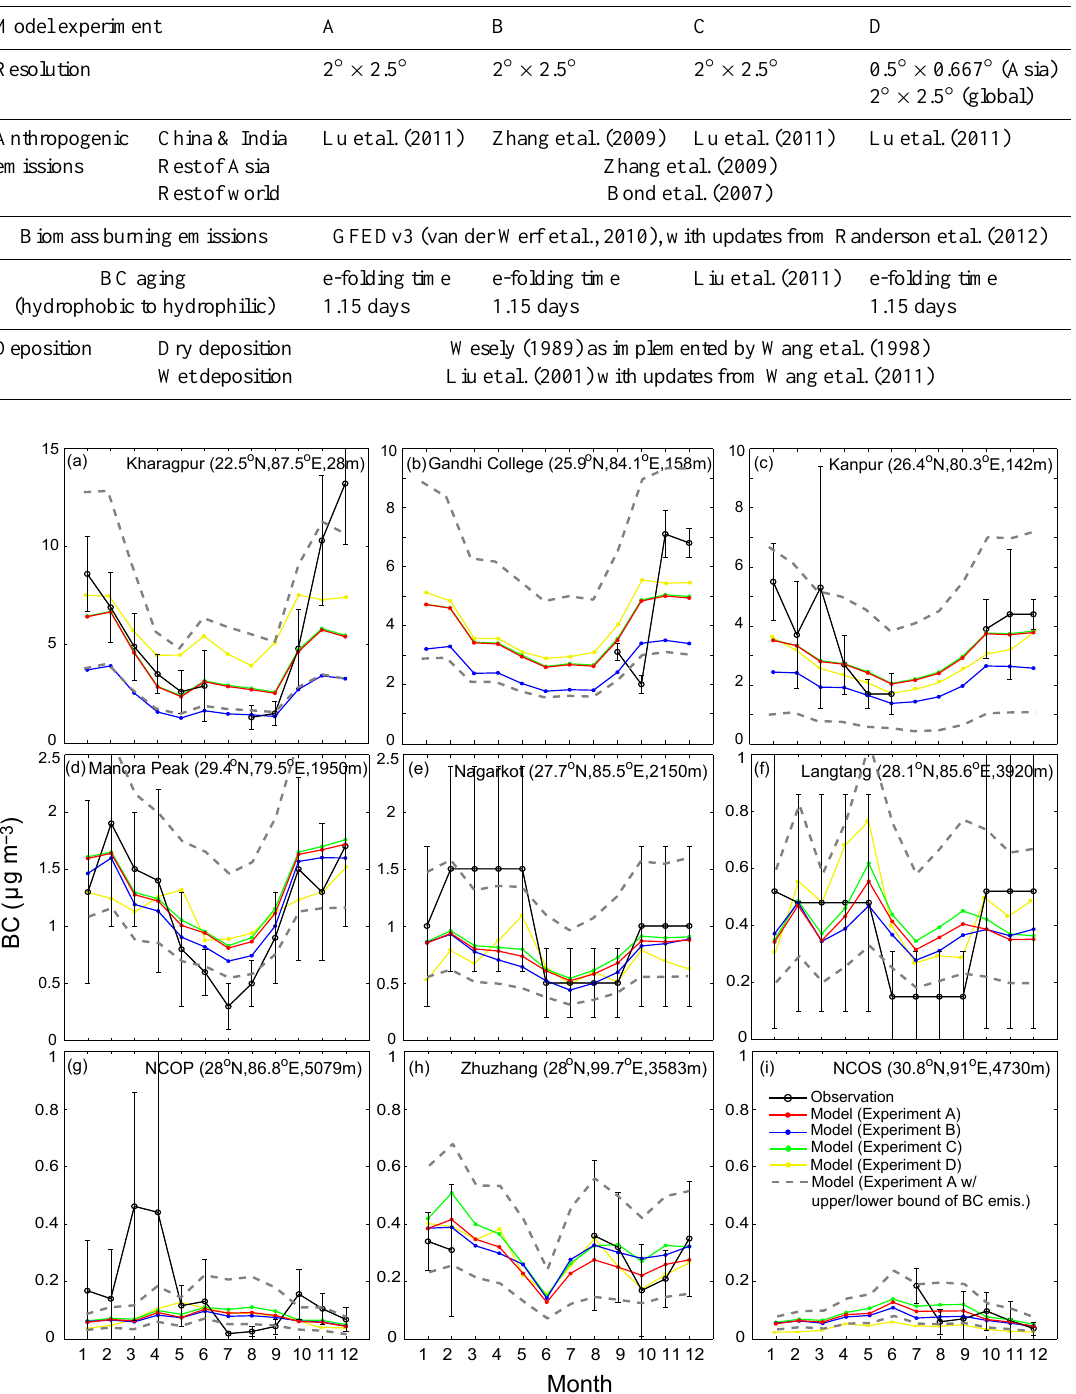
Figure 2. Observed (black curve) and GEOS-Chem simulated (colored curves: red – Experiment A; blue – Experiment B; green – Experiment C; yellow – Experiment D; grey dashed curves – Experiment A using upper/lower bounds of anthropogenic BC emissions in China and India) monthly mean surface-BC concentration (µgm − 3 ) at three rural sites (a–c) and six remote sites (d–i) over the Tibetan Plateau in 2006 (see Table 1 and Fig. 1). Only seasonal mean observations are available at sites e and f. Also shown are standard deviations for observations (error bars). See text for